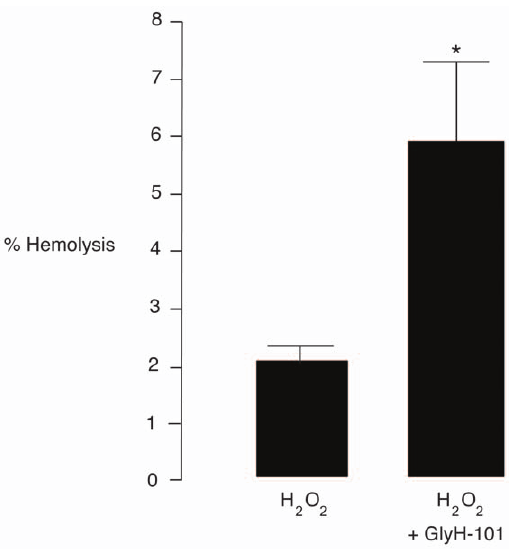
Figure 5. Effect of GlyH-101 on H 2 O 2 -induced osmotic toler- ance of beta thalassemia/Hb E erythrocytes. The erythrocytes were incubated with PBS containing H 2 O 2 (10 mM) with or without GlyH-101 (50 m M) at 37 u C for 3 h in a shaking incubator. After centrifugation and removal of supernatant, cells were exposed to hypotonic solution (85% PBS) and centrifuged at 1,500 g at 4 u C for 10 min. Absorbance of the supernatants was measured at 540 nm. Data were expressed as means 6 S.E. *, p , 0.05 compared with H 2 O 2 -treated group (n=10).